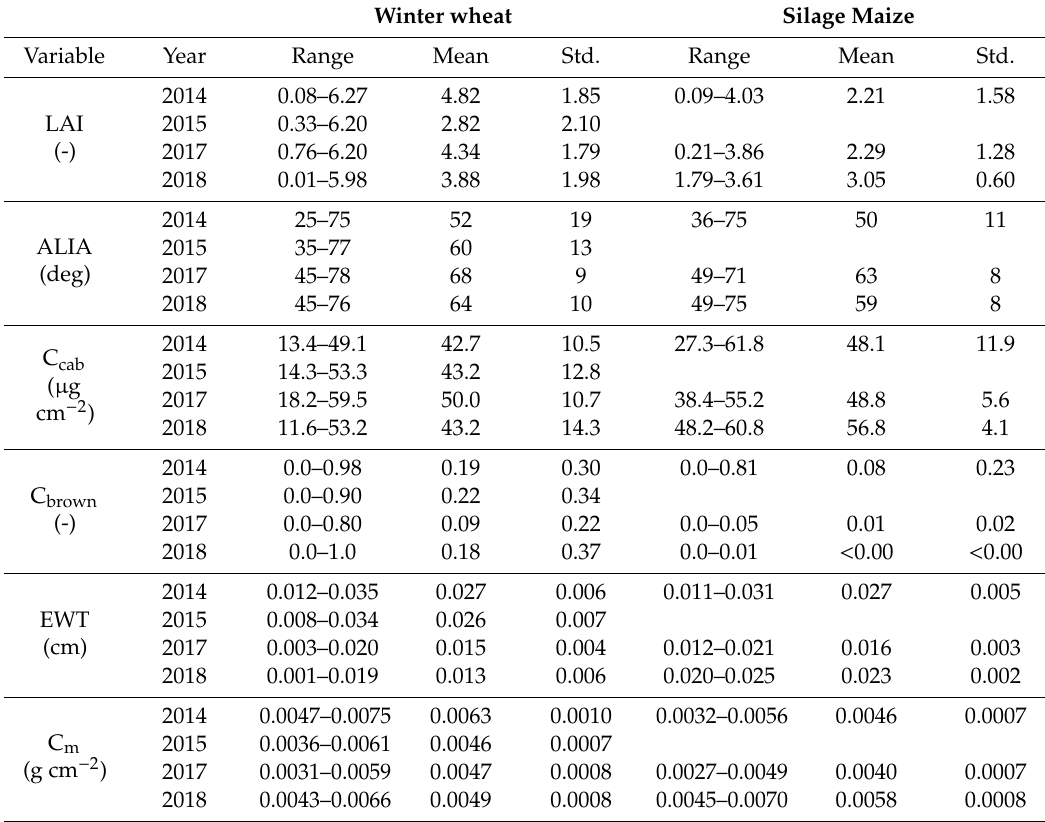
Table 3. Statistics of in-situ measured / estimated canopy variables of the four field campaigns at the MNI test sites.